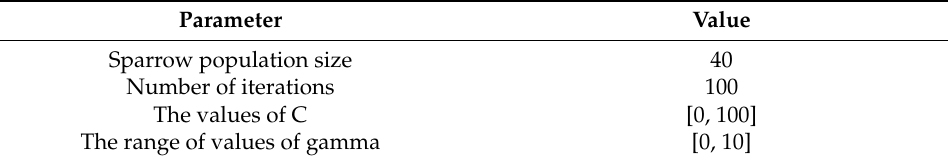
Table 2. Related parameter